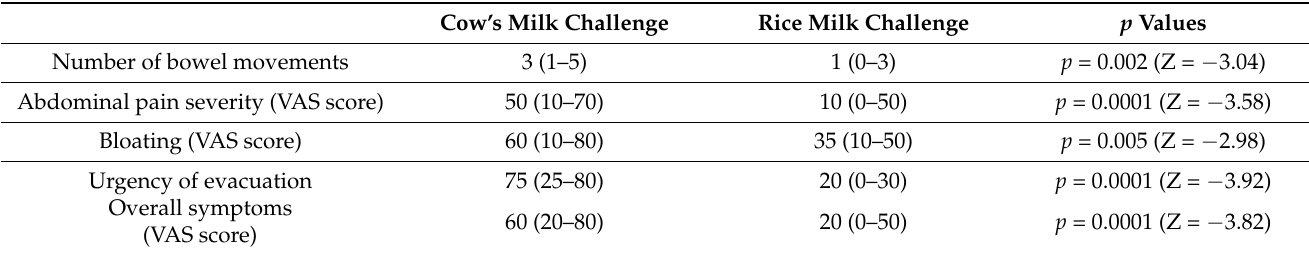
Table 3. Number of stool movements and severity of intestinal symptoms and overall symptoms in the 24 h following the cow’s milk and the rice milk DBPC challenges in the 42 patients with self-reported milk intolerance who tested negative at the H2-lactose breath test. Data are expressed as median and range. Cow’s Milk Challenge Rice Milk Challenge p Values Number of bowel